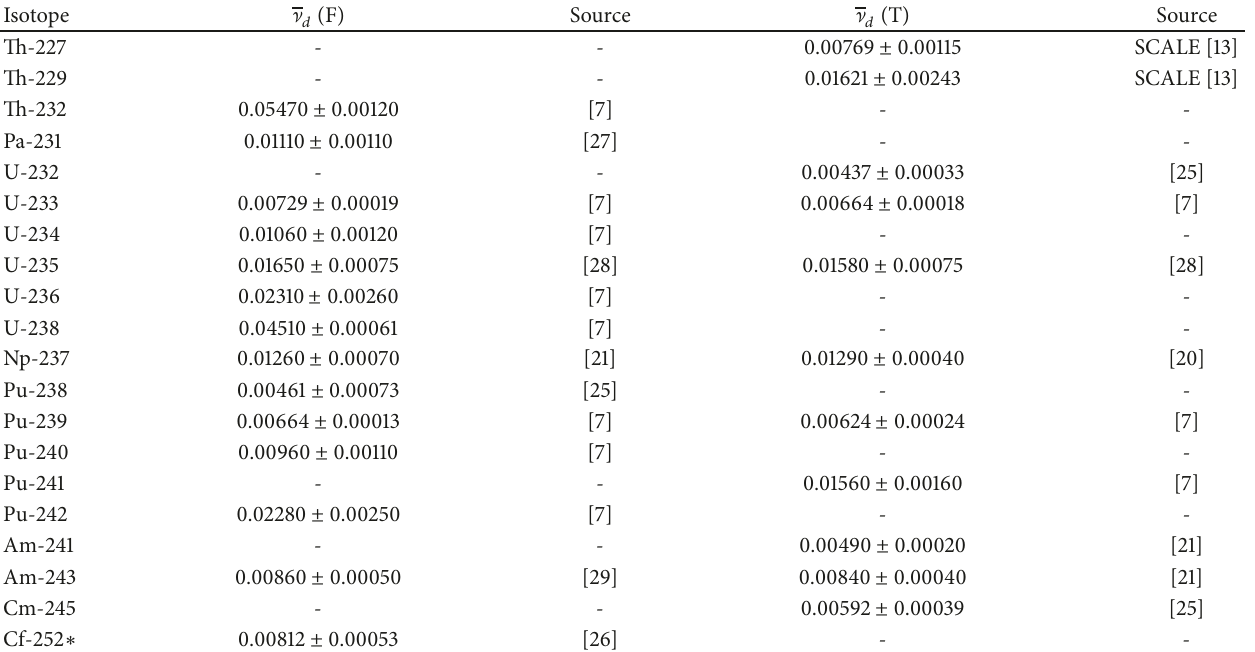
Table 3: Measured values of absolute delayed neutron yield ( ] 𝑑 ) for the selected actinides plus uncertainty collected from different sources.